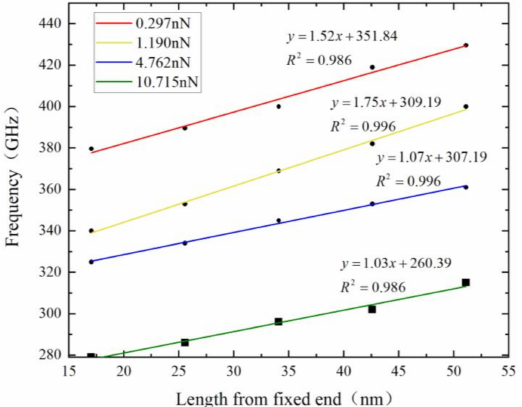
Figure 12. Variation of graphene resonant frequency with circular hole defect location under different external forces.